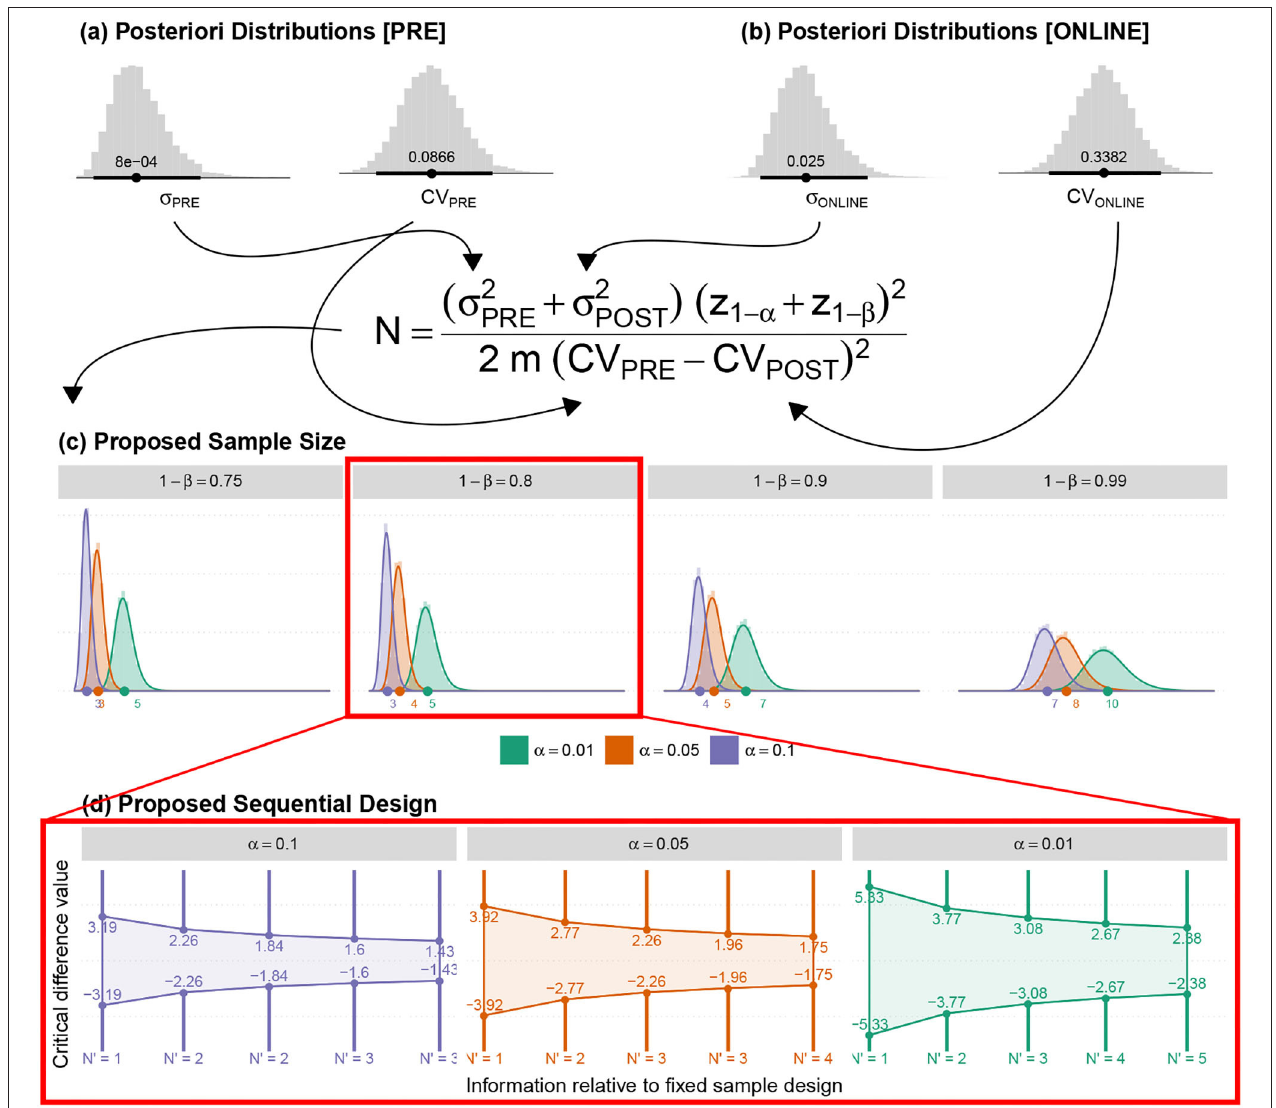
FIGURE 11 | (a,b) The posteriori distributions for the variances and Coefficient of Variance (CV) for the average responses (associated with the Pre and Online blocks) were obtained by adjusting the proposed model. (c) The posteriori distribution of the new sample sizes (based on fixed α , β and m ). (d) The suggested sequential sampling